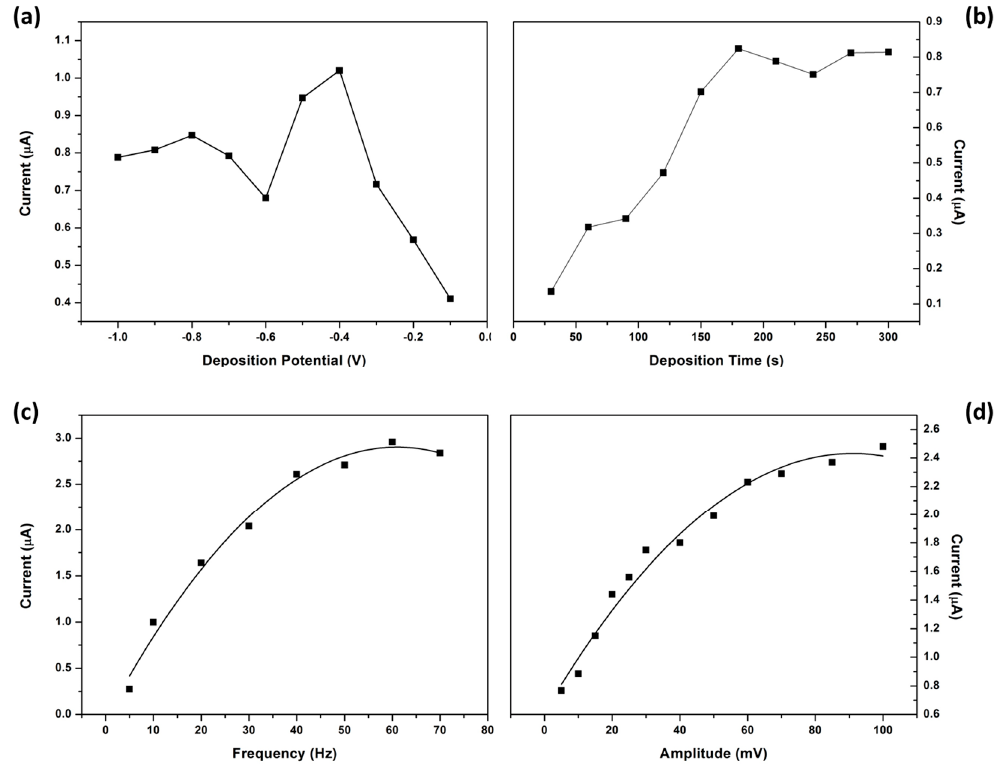
Figure 13. Effect of instrumental parameters; ( a ) deposition potential; ( b ) deposition time; ( c ) frequency and ( d ) amplitude on the stripping peak current of 10 µg L − 1 Ni 2+ at NGr-DMG-GCE. Supporting electrolyte (0.1 M NH 3 /NH 4 Cl Buffer (pH 9.3)).